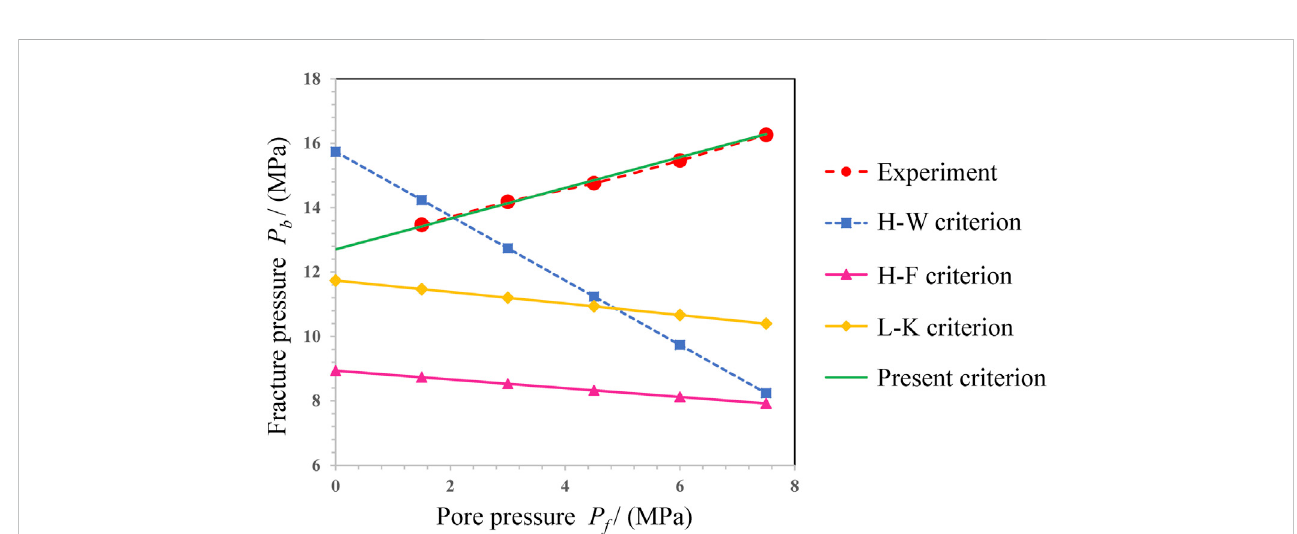
FIGURE 8 Comparison of rock fracture pressures predicted by different fracture criteria under variable pore water pressure.